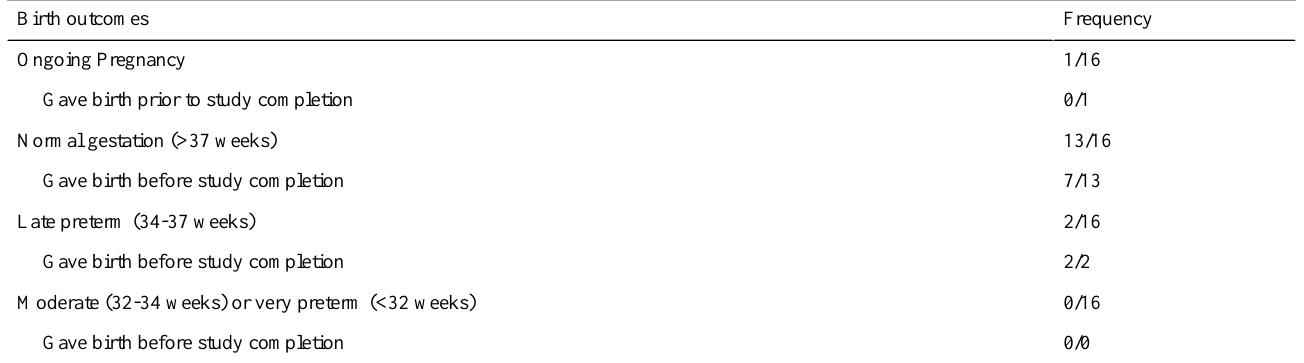
Table 4. Birth outcomes for the 16 pilot participants.